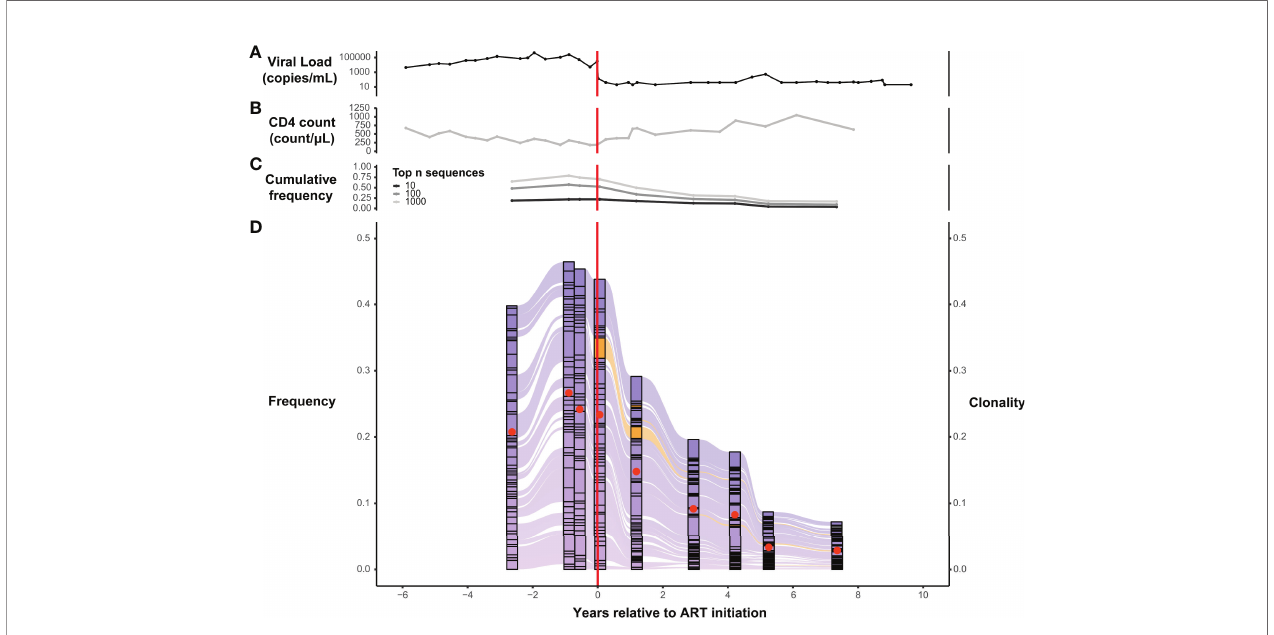
FIGURE 3 | T-cell b -chain repertoires from PLHIV are dominated by large clonal expansions that can persist for years following initiation of ART. Serial measurements obtained over a span of 14 years, before and after ART initiation, of HIV viral load (A) and CD4 + T-cell count (B) in a representative participant, 1001, from the PLHIV cohort. (C) Cumulative frequency of the most frequent 10, 100, and 1000 TRB CDR3 amino acid sequences in the blood TRB repertoire of participant 1001 measured at 9 different timepoints over a 10-year interval spanning the initiation of ART. (D) Alluvial plot of the 9 different TRB repertoires from participant 1001 showing the variation in frequency (left axis) of the 50 most frequent TRB CDR3 amino acid sequences in the blood. Sequences fi rst observed before ART initiation are colored purple and those fi rst observed after ART initiation are colored orange. The clonality (right axis) of each repertoire is represented as a fi lled (tangerine) circle superimposed on the corresponding component of the alluvial plot. Dashed vertical red line indicates the timing of ART